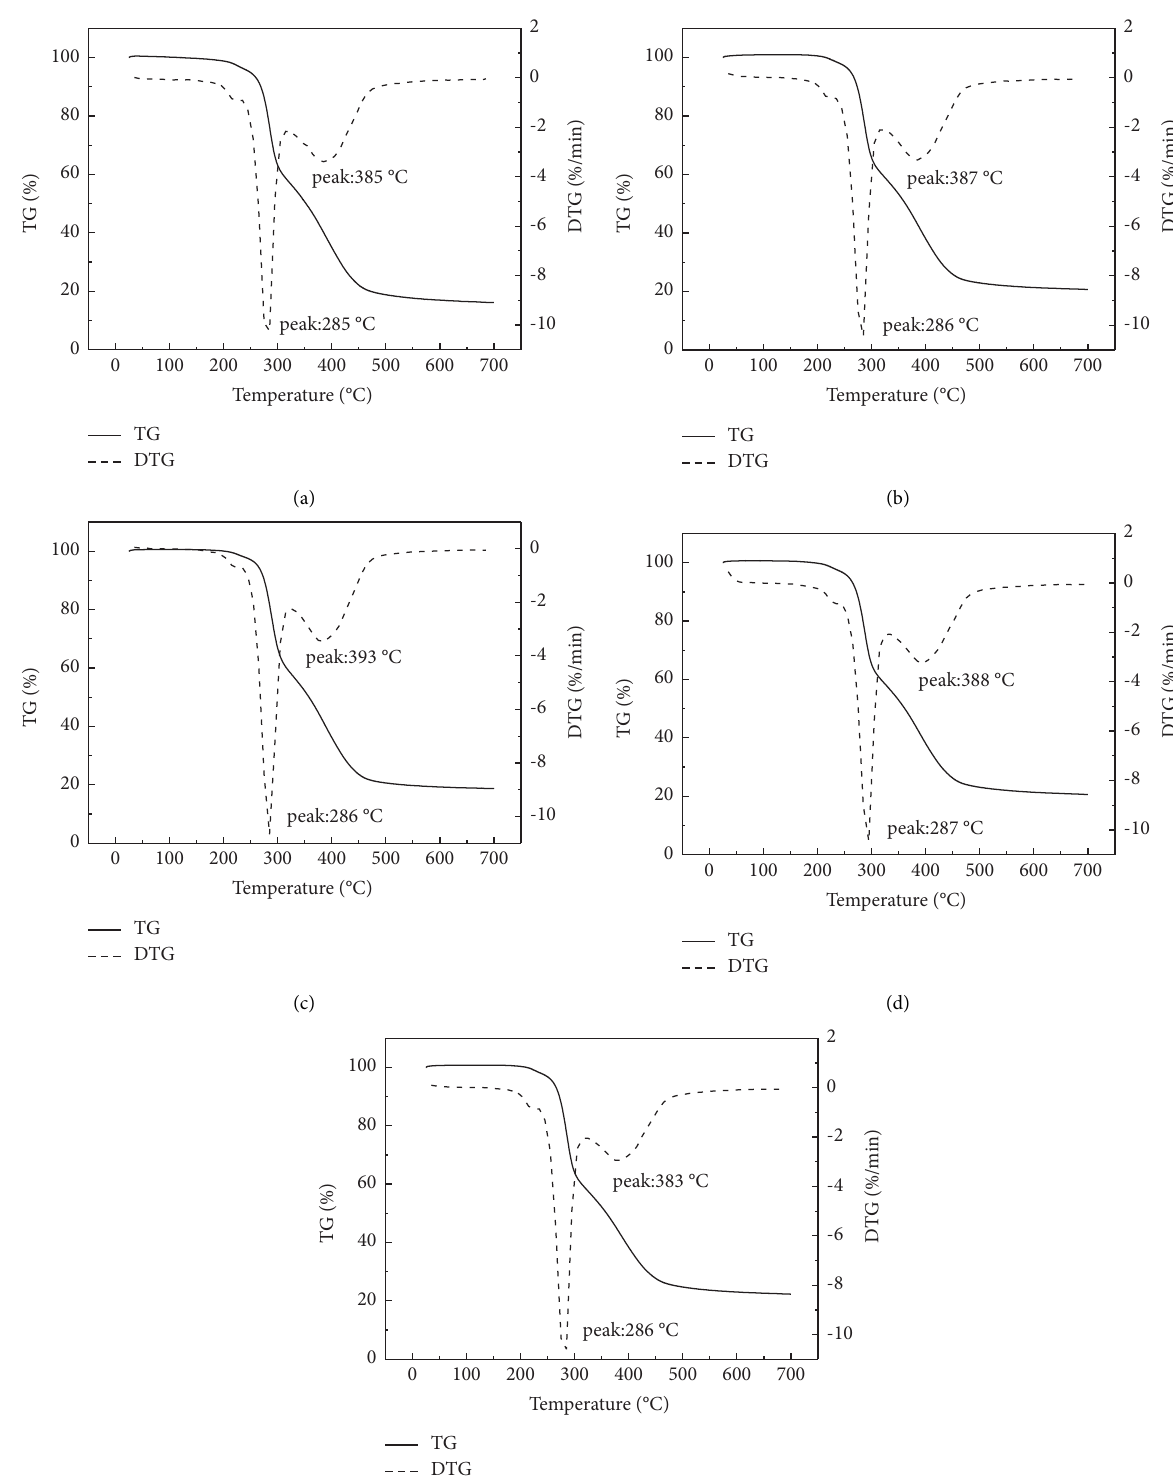
Figure 3: Efect of the WS :WG ratios on the thermal parameters of the crust. (a–e) refer to the WS :WG ratios of 15:1, 13:1, 11 :1, 9:1, and 7:1 w/w,